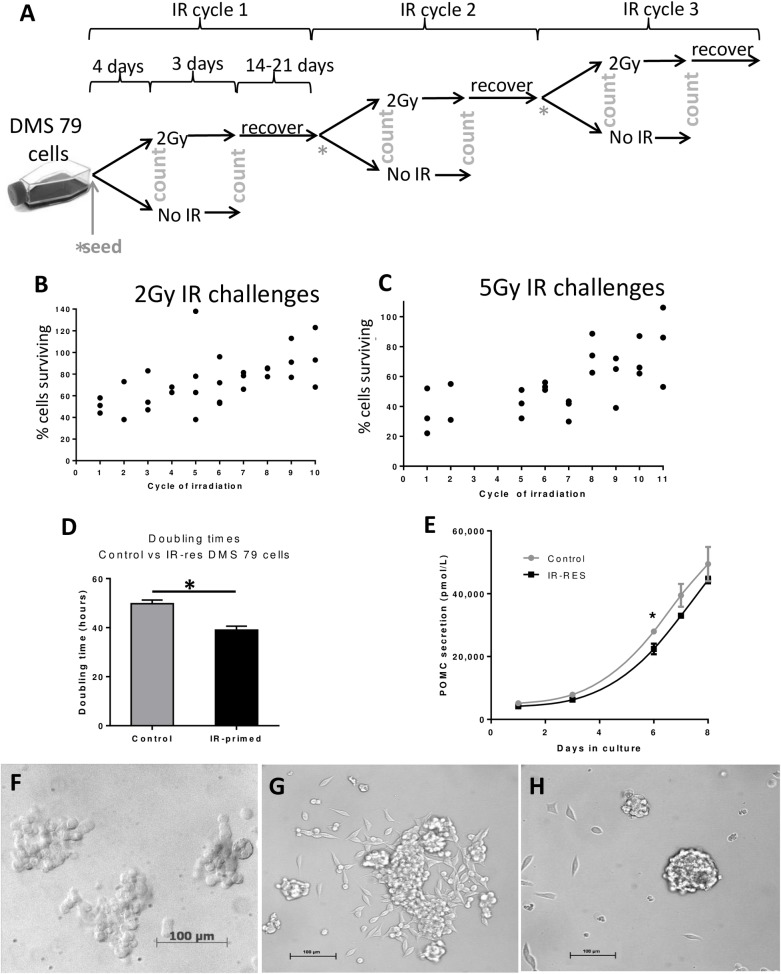
IR-primed DMS 79 cells acquire resistance to irradiation in vitro.DMS 79 cells were irradiated at 2Gy for 10 progressive cycles (schematic [A]). The percentage of cells surviving in the irradiated cultures was compared to ‘control’ ie cells not treated at that particular cycle (B) (Spearman correlation p = <0.0001). The experiment was conducted with these controls to allow for the increased proliferation that irradiated cells displayed over time compared to completely untreated cells. DMS 79 cells were also challenged with higher doses of IR (5Gy) at various points to evaluate radiosensitivity (C). Cells remaining were expressed as a percentage of controls (B&C). Cell doubling times of untreated vs 21Gy IR cells (9 total cycles, 8 of 2Gy and 1 of 5Gy) were calculated over 5 days (D). POMC secretion was assessed over 8 days by POMC ELISA and results were normalized to cell number (E). Cell morphology of untreated DMS 79 cells (F). Cell morphology of cells irradiated to 21Gy, displaying adherent colonies and individual adherent elongated cells (G) and very tightly suspended clusters (H) compared to the loose suspended clumps shown in (F).